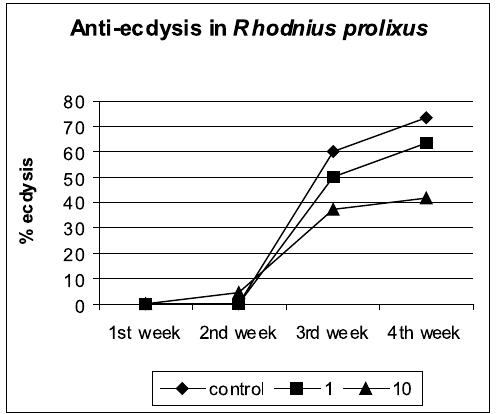
Fig. 4 – Anti-molting activity of ( 1 ). Concentrations in µ g/ml. data base 1948-1998).